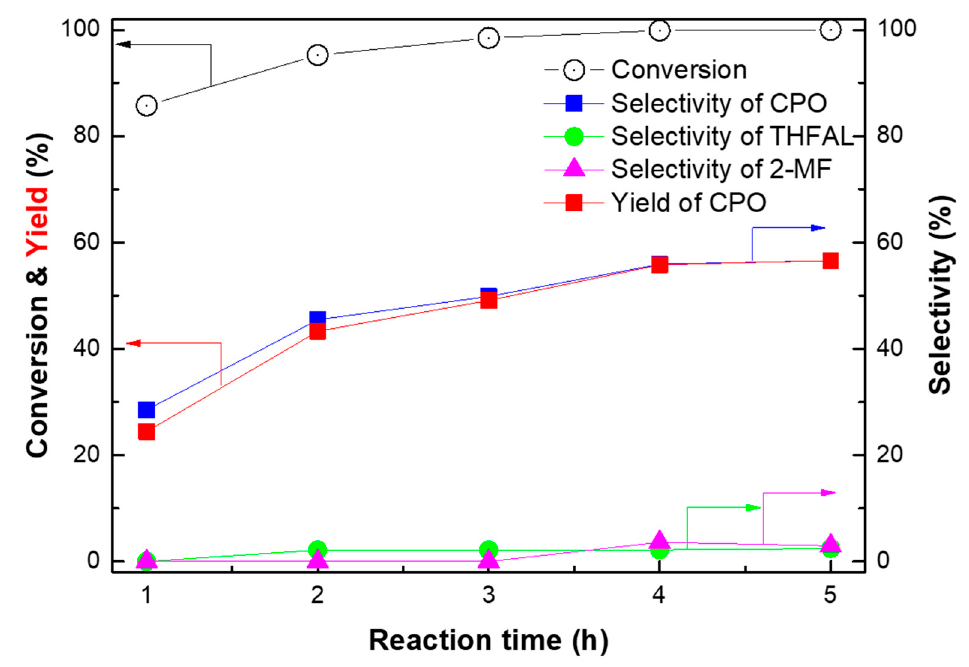
Figure 10. E ff ect of reaction time on furfural conversion, products selectivity and CPO yield in Pd / TiO 2 catalyst.